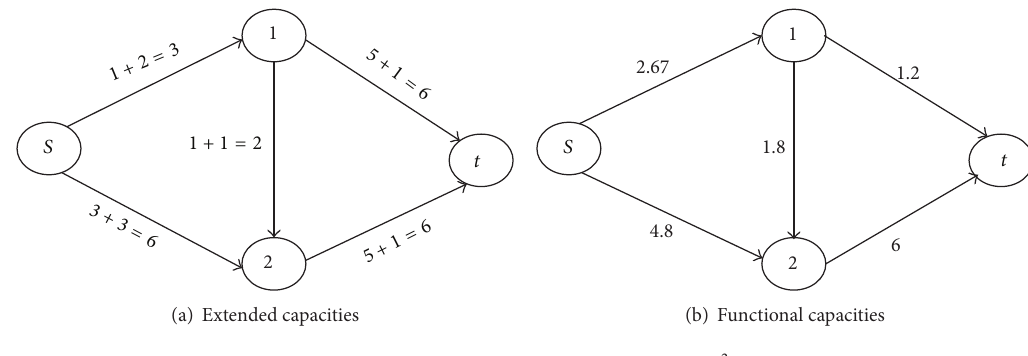
Figure 4: The result of running CEA using 𝐴 2 .